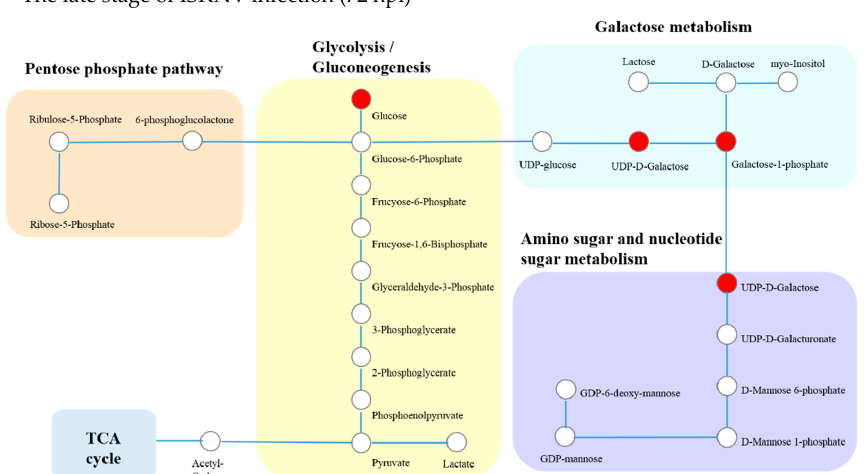
Figure 4. Integrated networks of ISKNV infection outlining biochemical pathways related to glycolysis / gluconeogenesis, the pentose phosphate pathway, galactose metabolism, and amino sugar and nucleotide sugar metabolism. Metabolites are represented by circles. Changes in the levels of metabolites (circles) relative to the control groups are color-coded to represent up-regulation (red) or down-regulation (green). Colorless boxes indicate that no di ff erence was detected. Metabolomics data were collected from six groups of parallel samples of CPB cells using UHPLC-Q-TOF / MS. Abbreviations: hpi, hours